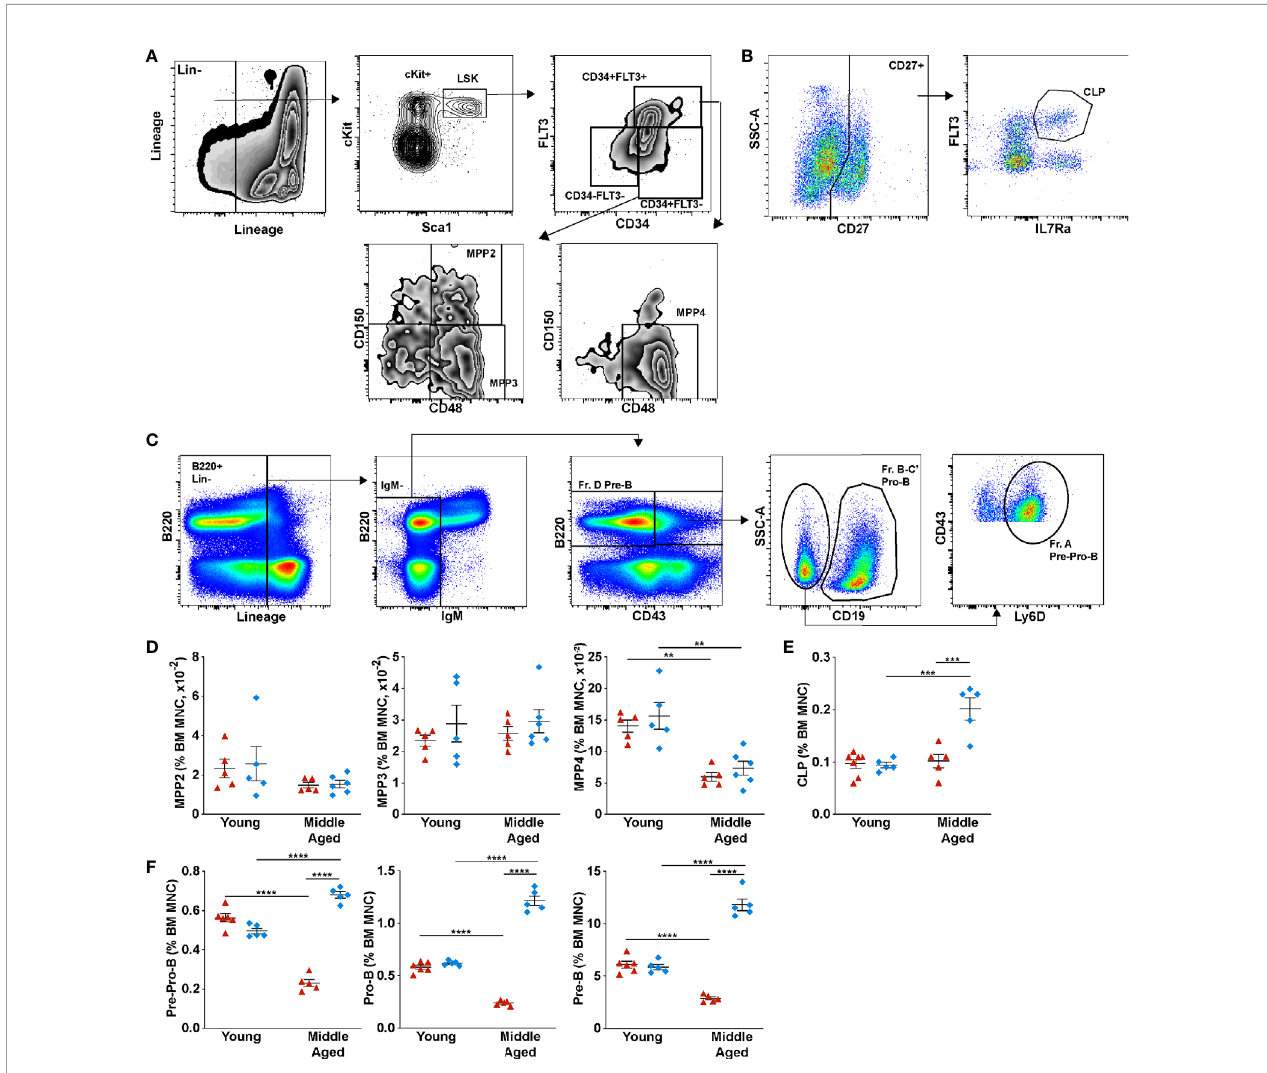
FIGURE 2 | Microbiota signals suppress B lymphopoiesis through down-regulating common lymphoid progenitors in aged mice. (A) Representative fl ow plots of young SPF mouse BM showing the gating strategy used to identify multipotent progenitor (MPP) populations MPP2 (lineage – Sca1 + Kit + CD34 + FLT3 – CD48 + CD150 + ), MPP3 (lineage – Sca1 + Kit + CD34 + FLT3 – CD48 + CD150 – ), and MPP4 (lineage – Sca1 + Kit + CD34 + FLT3 + CD48 + CD150 – ). (B) Common lymphoid progenitors (lineage – CD27 + FLT3 + IL7R a + cells) (C) B cell progenitors Pre-Pro-B (lineage – B220 + IgM – CD19 – CD43 + Ly6D + cells), Pro-B (lineage – B220 + IgM – CD19 + CD43 + cells), and Pre-B (lineage – B220 + IgM – CD43 – cells). (D) Percent of multipotent MPP2, MPP3, and MPP4 per femur. (E) Percentage of common lymphoid progenitors (F) Percentage of Pre-Pro-B cells, Pro-B cells, Pre-B cells and Immature B cells (lineage – B220 + IgD – IgM + cells) in the bone marrow. Data represent the mean ± SEM. **P < 0.01, ***P < 0.001, and ****P < 0.0001 by one-way ANOVA with alpha = 0.05 and Sidak ’ s multiple comparisons